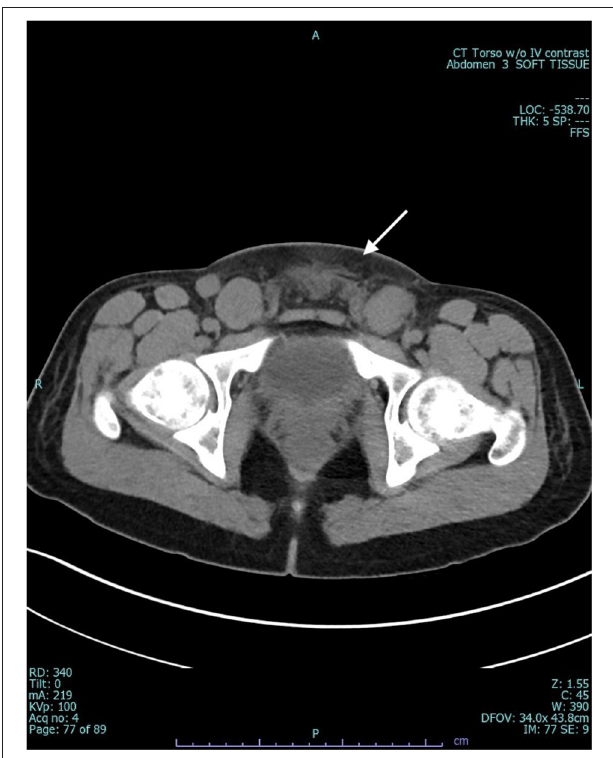
FIGURE 2 | CT pelvis at admission demonstrating bilateral inguinal lymphadenopathy and subcutaneous fat stranding of lower abdominal